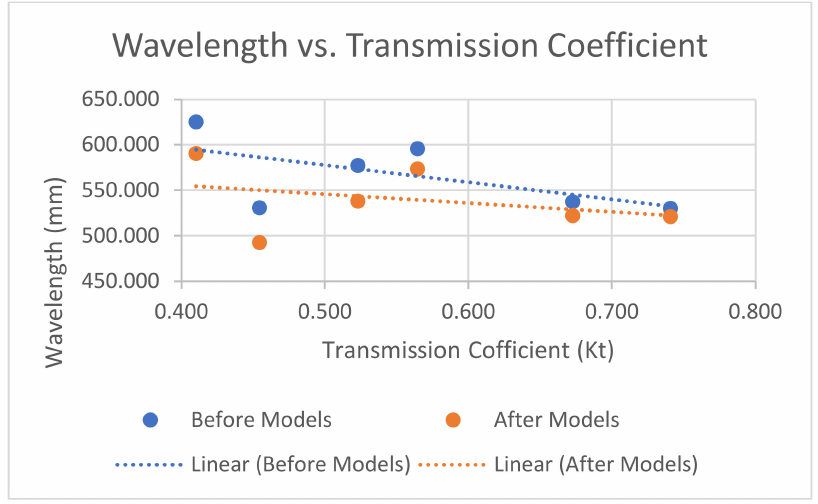
Figure 7. Variation of the wavelength with the transmission